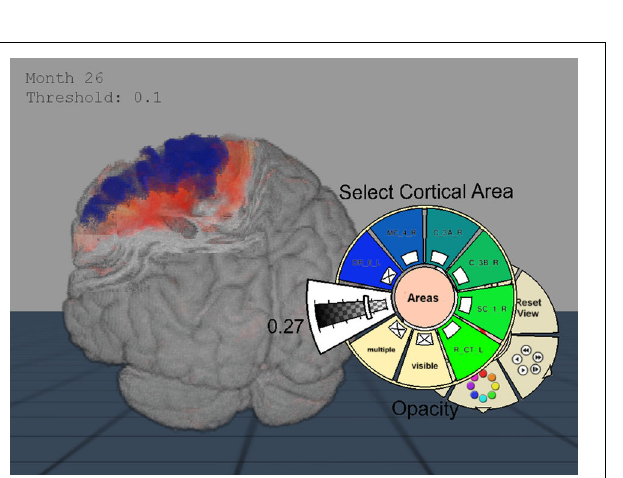
FIGURE 3 | Importance-Driven Volume Rendering Design: A view-dependent cutout is created to the premotor cortex area (blue). Furthermore, this screenshot shows the application when changing the opacity of the cortical area via pie